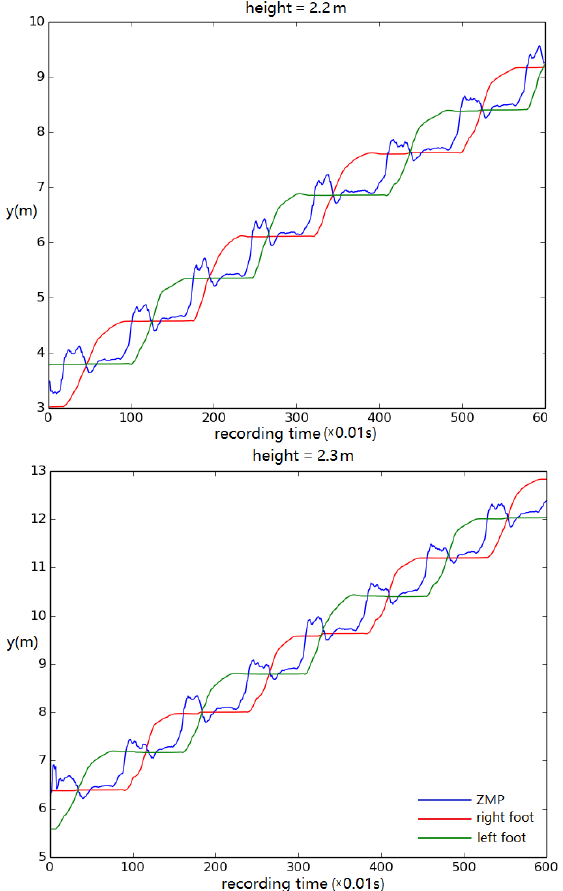
Figure 14. Foot and ZMP displacement when the body height is set to ( top ) 2.2 m and ( bottom ) 2.3 m. Displacement of torso center of mass vs. time.